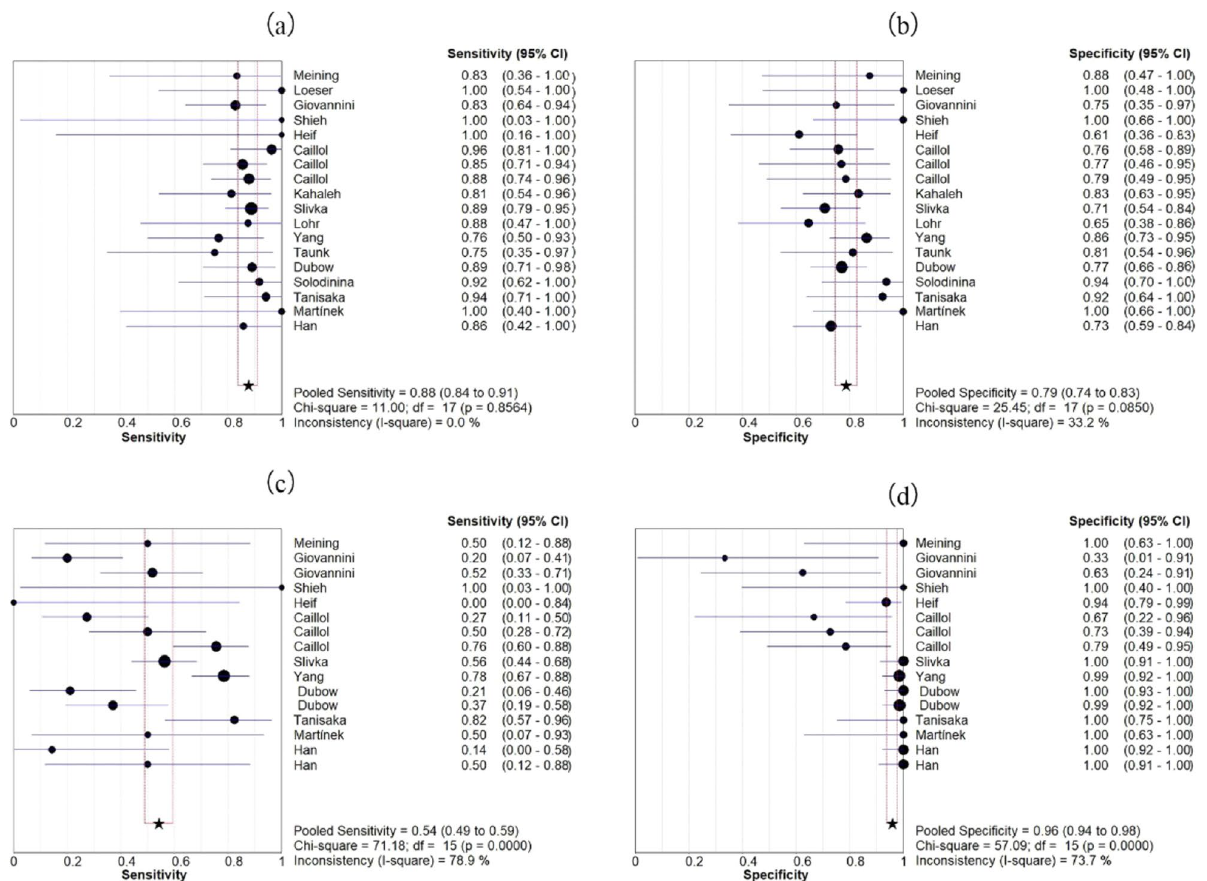
Figure 3. Forest plot of sensitivity and specificity of pCLE ( a , b ) and tissue sampling by ERCP ( c , d ) in diagnosing indeterminate biliary